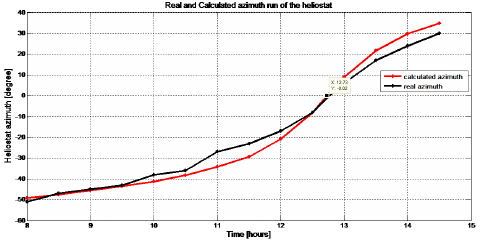
Fig. 13. Comparison between the real and calculated azimuth run of the heliostat are highly sensitive and